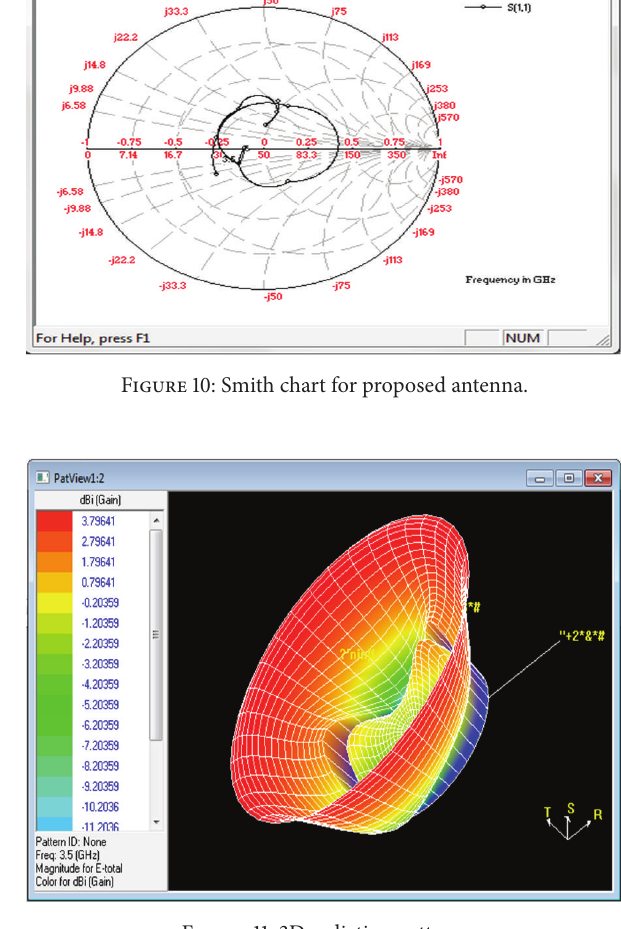
Figure 11: 3D radiation pattern.